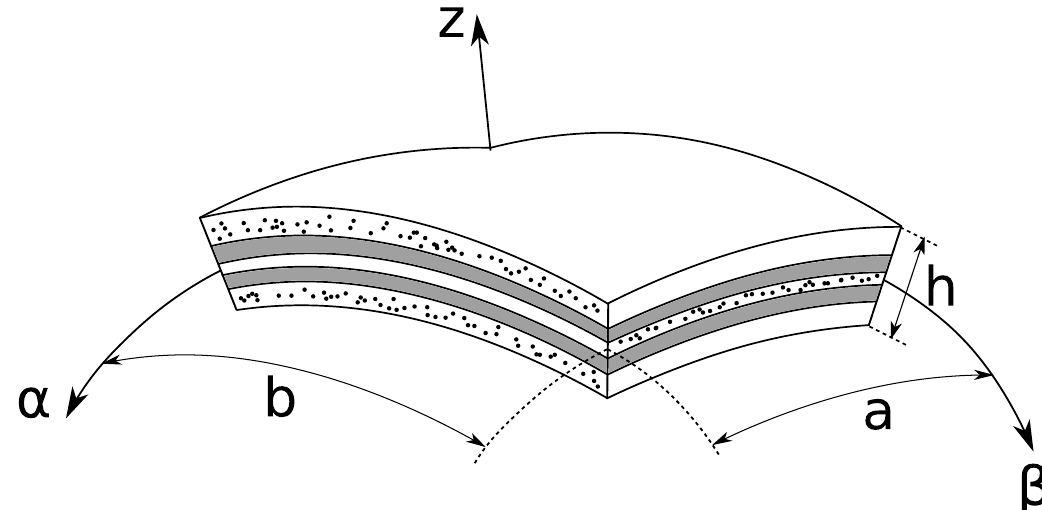
Figure 1. Reference system and geometry of the multilayered viscoelastic